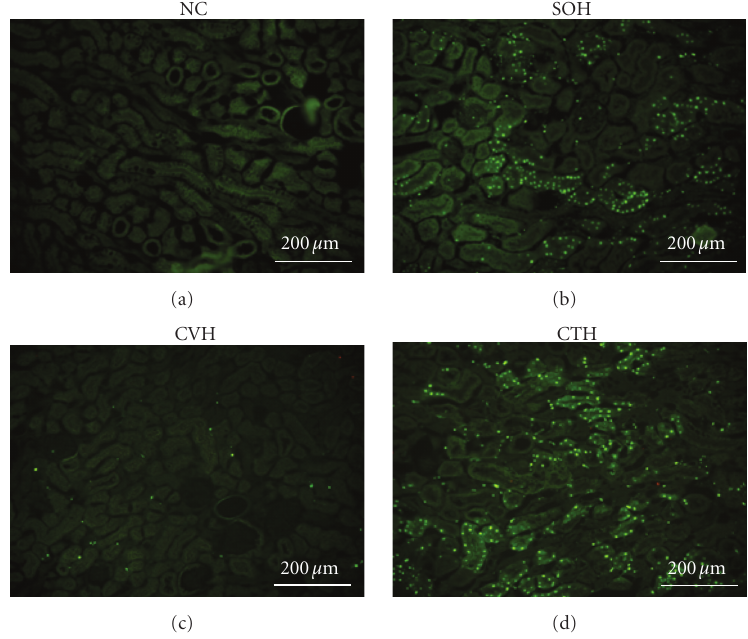
Figure 7: Photomicrographs of TUNEL staining of the kidney for an NC mouse, a SOH mouse, a CVH mouse, and a CTH mouse.